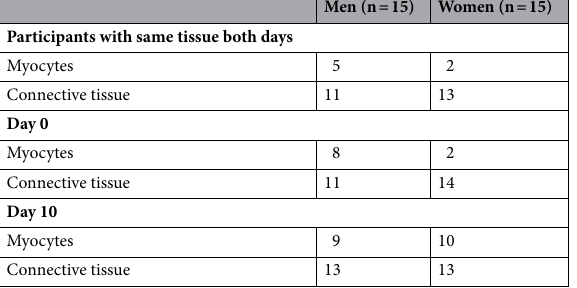
Table 1. The number of participants. The table presents the number of participants whose biopsies contained myocytes and connective tissue on both days. Moreover, it shows the number of participants whose biopsies contained myocytes and connective tissue on day 0 and day